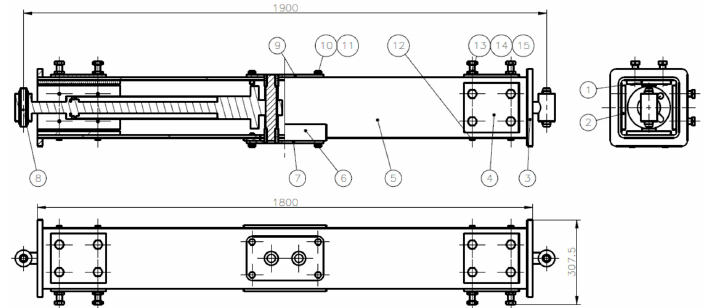
Figure 7. Axle assembly diagram. 1, 2. sliding plate; 3. wheel edge limit plate; 4. thickening plate; 5. bridge shell; 6. strengthening plate; 7, 9. window cover plate; 8. wheel distance adjustment hydraulic